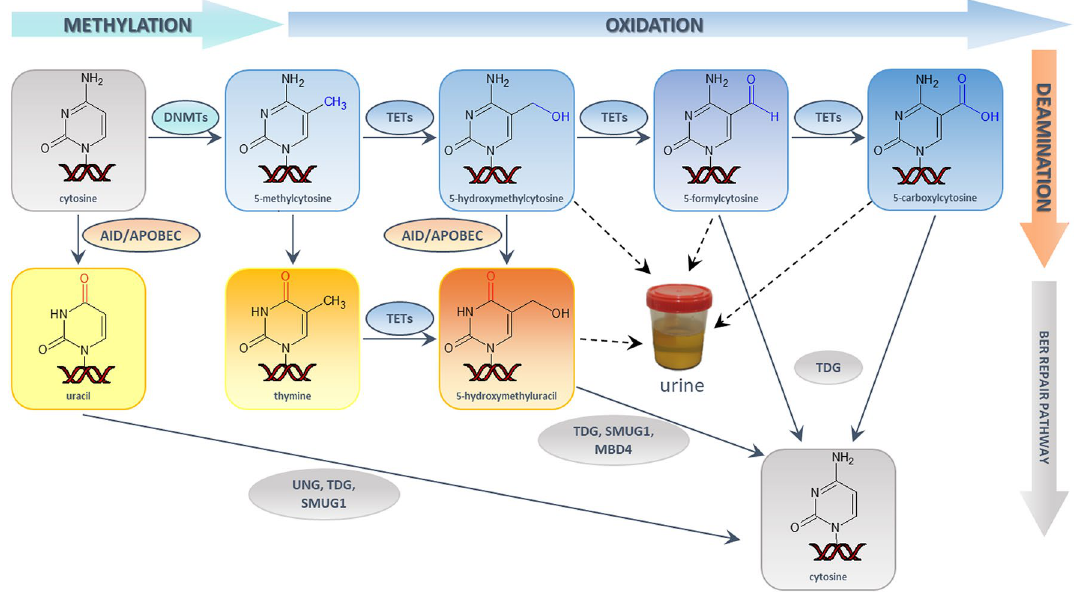
Figure 1. The cytosine methylation and active demethylation pathway. ( DNMT 4: DNA methyltransferase, TETs: ten eleven translocation enzymes, AID: activation-induced cytosine deaminase, APOBEC: apolipoprotein B mRNA editing enzyme, TDG: thymine DNA glycosylase, SMUG1: single-strand-selective monofunctional uracil-DNA glycosylase 1, UNG: uracil-DNA glycosylase, MBD4: methyl-CpG-binding domain protein 4, BER: base excision repair). Reprinted from Biochimica et Biophysica Acta—Reviews on Cancer, 1869 (1), Olinski R, Gackowski D, Cooke M. Endogenously generated DNA nucleobase modifications source, and significance as possible biomarkers of malignant transformation risk, and role in anticancer therapy, 29–41 (2018), with permission from Elsevier.